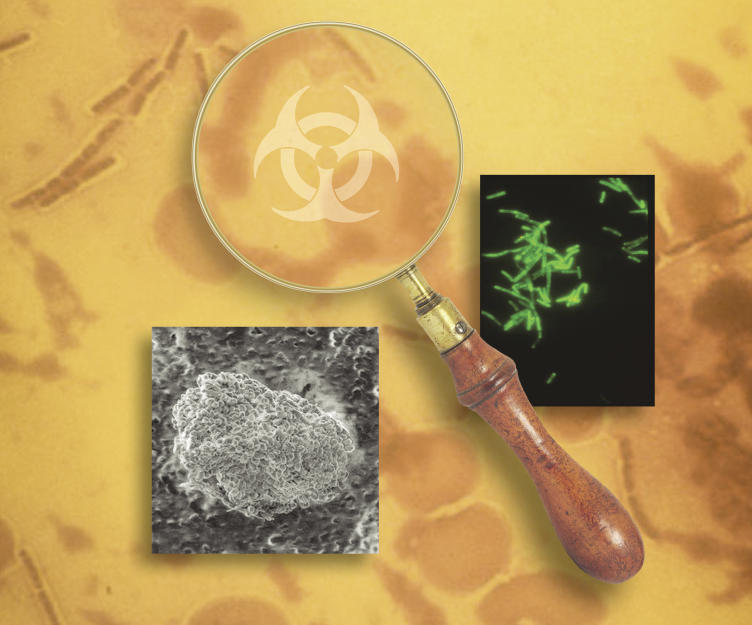
(Reprinted cover image from [30] with permission from Elsevier)